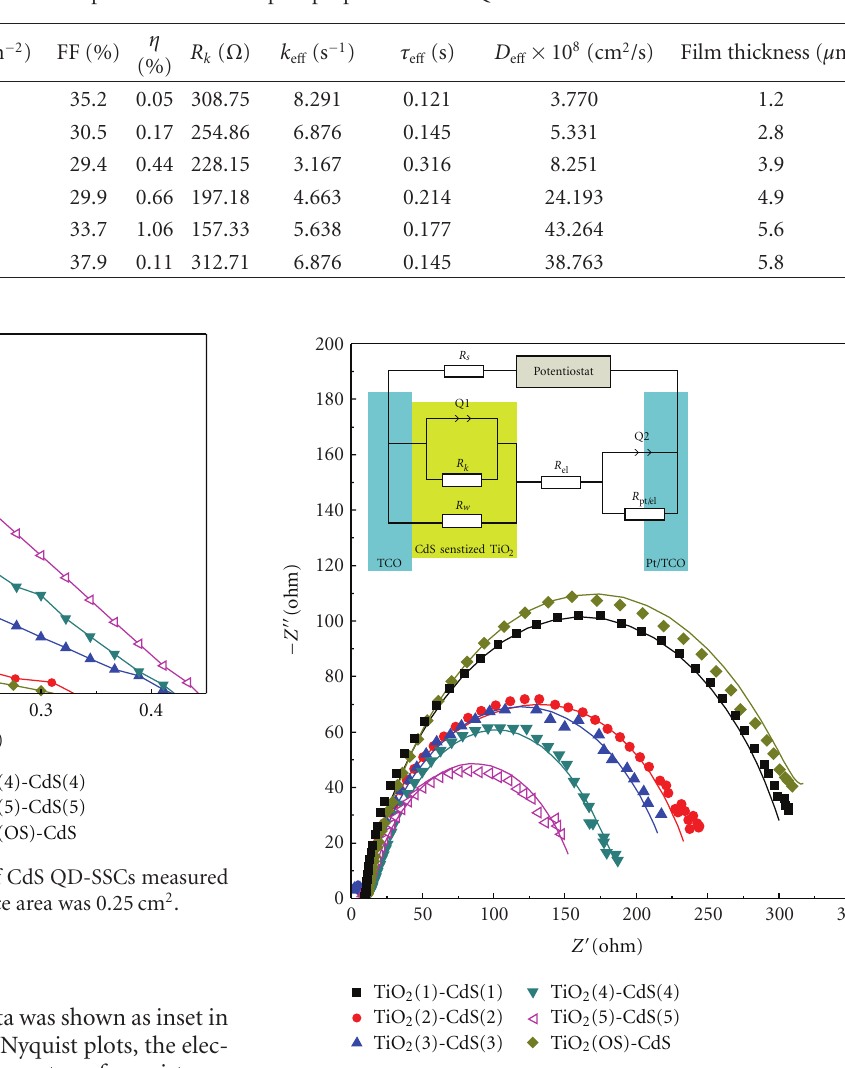
Figure 5: Experimental (dots) and fitted (solid curve) Nyquist plots of CdS QD-SSCs under AM1.5 condition. The equivalent circuit used to fit the experimental data was shown as